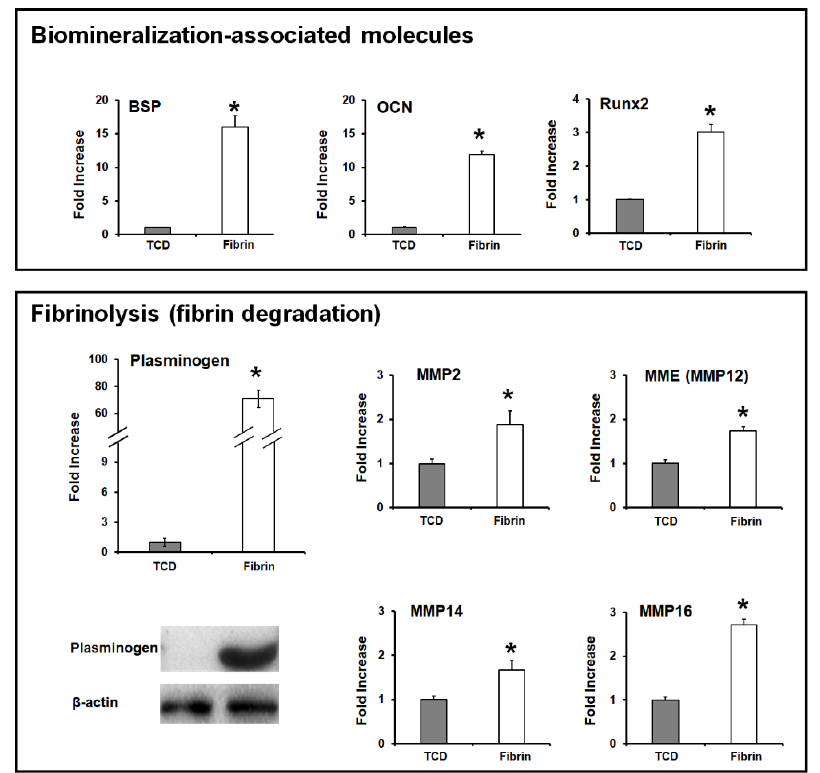
Figure 8. Cementoblast cell activations for biomineralization and fibrinolysis. The fibrin hydrogel matrices for the cementoblast cell culture could activate the canonical Wnt signaling pathway to promote the higher expression of biomineralization-associated molecules like bone sialoprotein (BSP), osteocalcin (OCN), and Runx-related gene 2 (Runx2) (upper panel). Simultaneously, cementoblast cells could have a significantly high expression level of plasminogen on fibrin hydrogel matrices rather than tissue culture dish (TCD) environments. Moreover, expressions of fibrinolytic elements like matrix metalloproteinases (MMPs) increased during cementoblast cell cultivation on fibrin hydrogel matrices (lower panel). * p < 0.05. Adapted with permission from the reference [82].